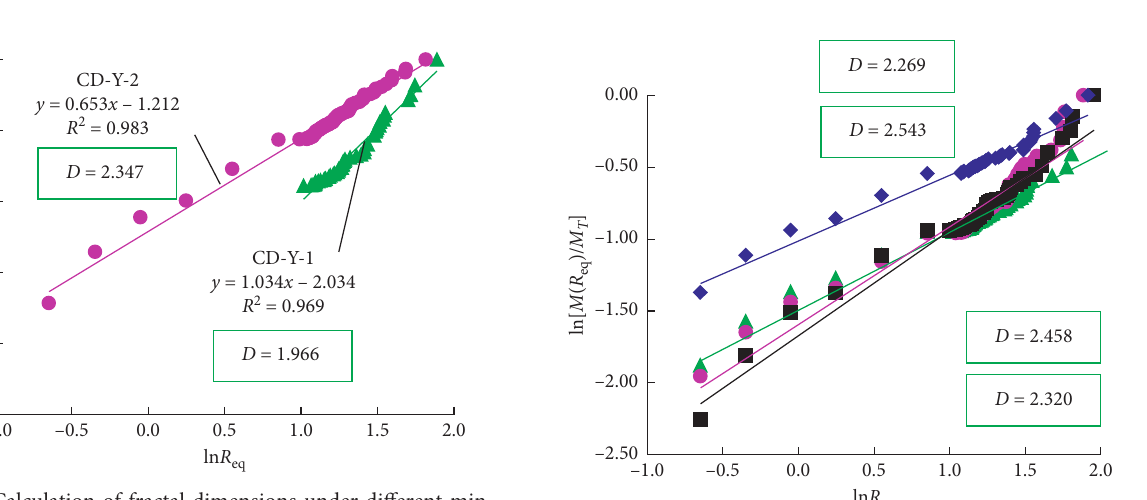
Figure 5: Calculation of fractal dimensions under different maximum static stress σ z .